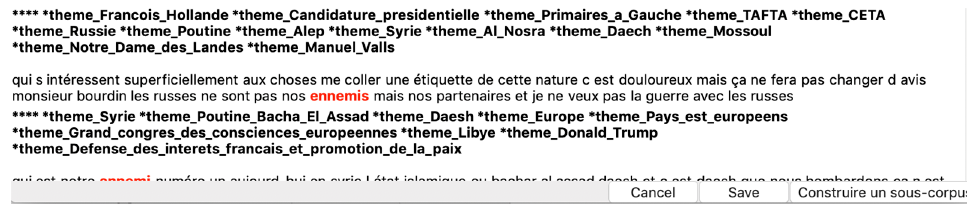
Figure 3. Extraction of the subcorpus.